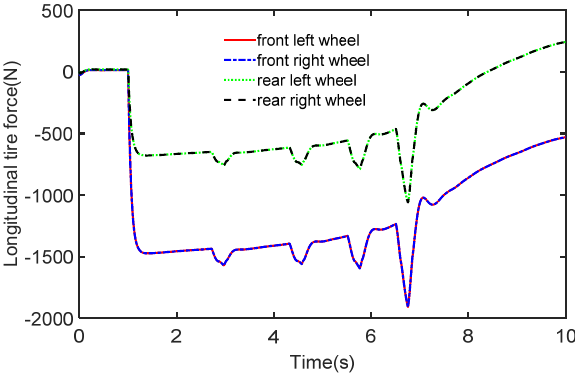
Figure 10. The acceleration in the case of deceleration.